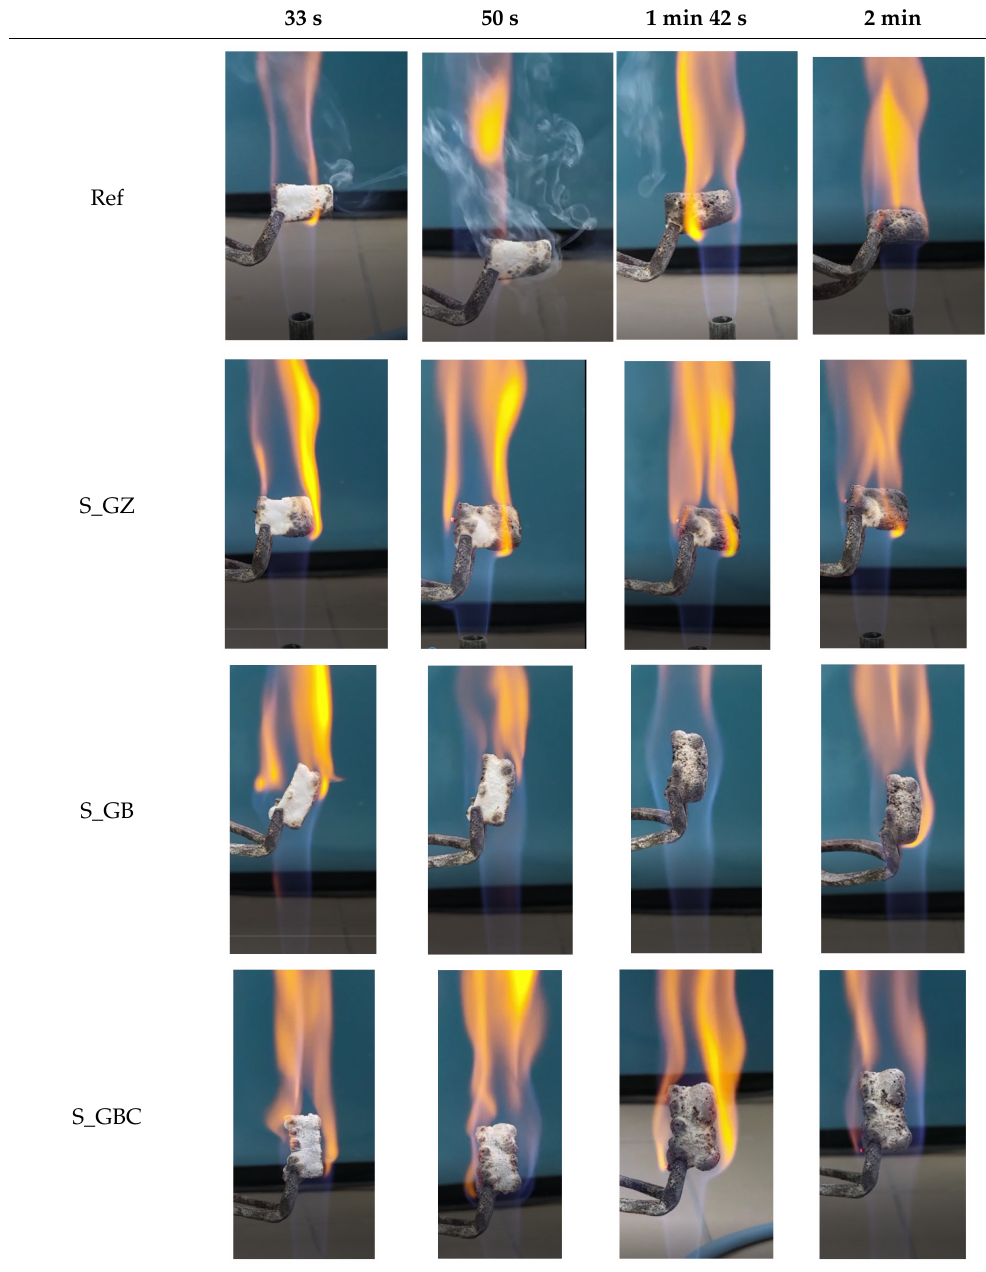
Table 2. Visual aspect of samples during direct contact with the